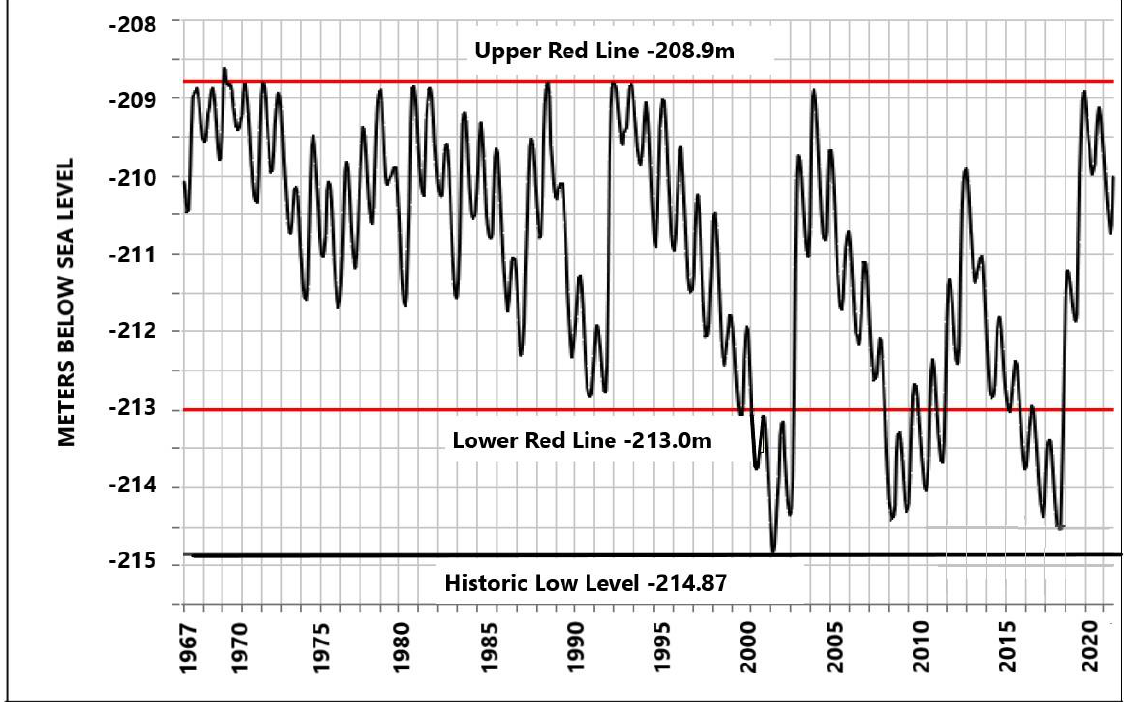
Figure 5. Change in Sea of Galilee level 1967 – 2022. (Note: Upper red line is the level at which a dam at the southern outlet is to be opened to allow flow into the Lower Jordan River to prevent flooding around the shores of the Sea of Galilee. The Lower red line is an administrative goal below which water levels are not supposed to drop in order not to cause high salinity and risk permanent ecological damage.) Source: adapted from (IWA, 2022). https://www.gov.il/he/Departments/news/ news-kinneret (accessed on 14 January